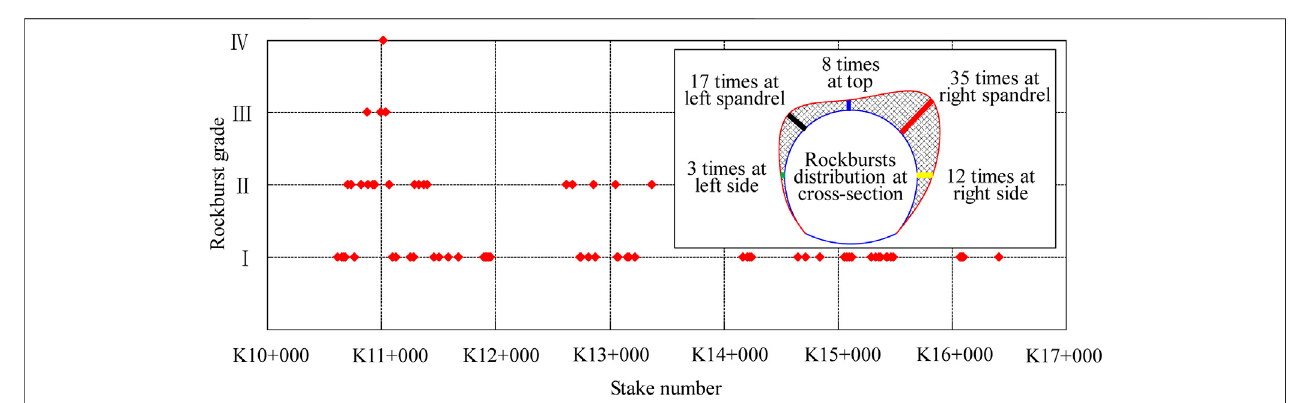
Frontiers in Earth Science |